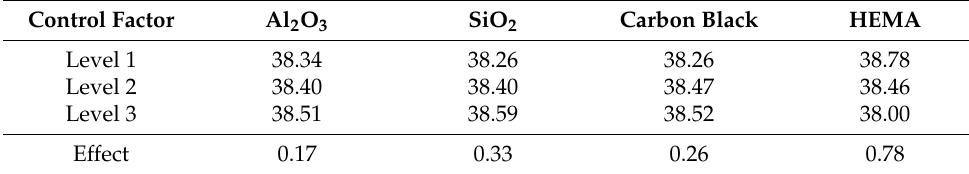
Table 5. Reaction table for the S/N ratio of glass transition temperature (unit: dB). Control